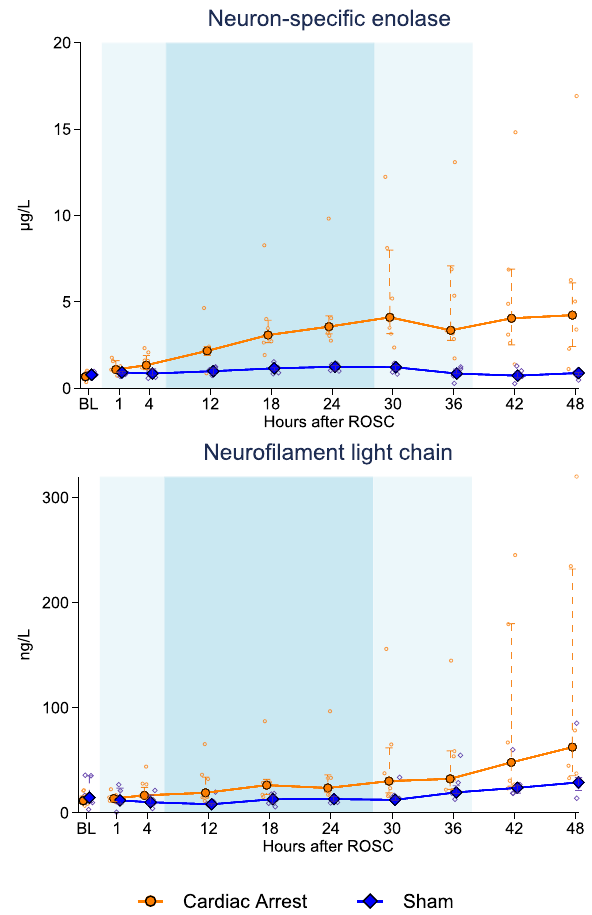
Fig. 4 Level of neuron-specific enolase and neurofilament light chain over time in the cardiac arrest and sham groups. Data are presented as median [25%; 75%] with overlaid scatter plots representing each animal. Lighter blue shading indicates induction or rewarming phase, while darker blue shading indicates maintenance phase of targeted temperature